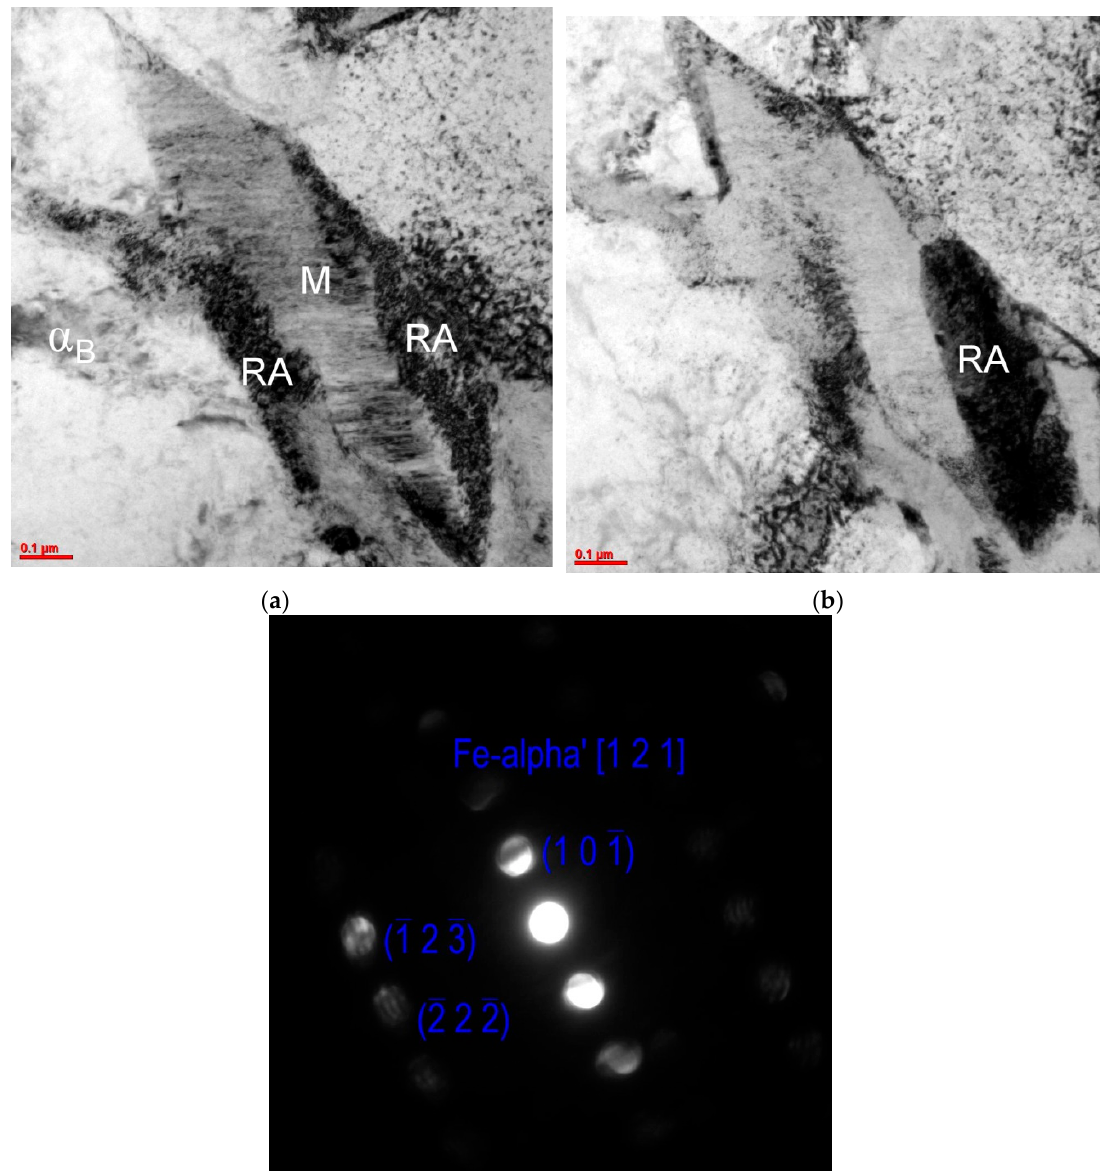
Figure 12. A middle part of the austenite layer transformed to fine-plate martensite in a sample deformed to 10%; a bright field with the contrast on martensite (M) ( a ), a bright field with a contrast on retained austenite (RA) ( b ), microdiffraction from the martensitic plates area ( c ).